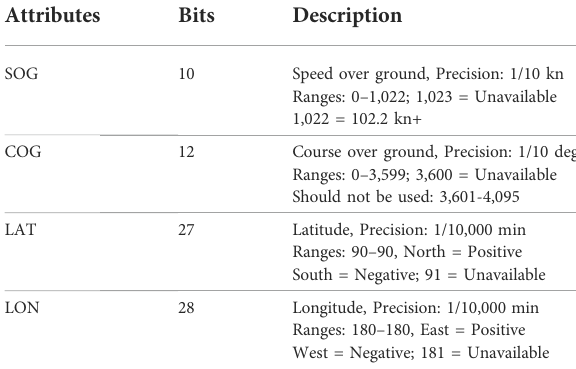
TABLE 1 Description of important AIS attributes.